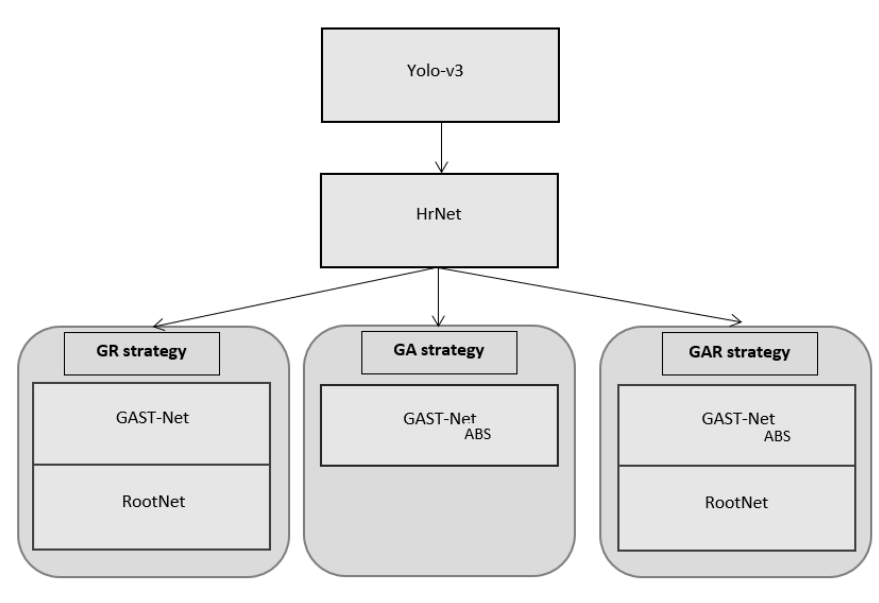
Figure 4. The structural diagram of the various types of networks used in the